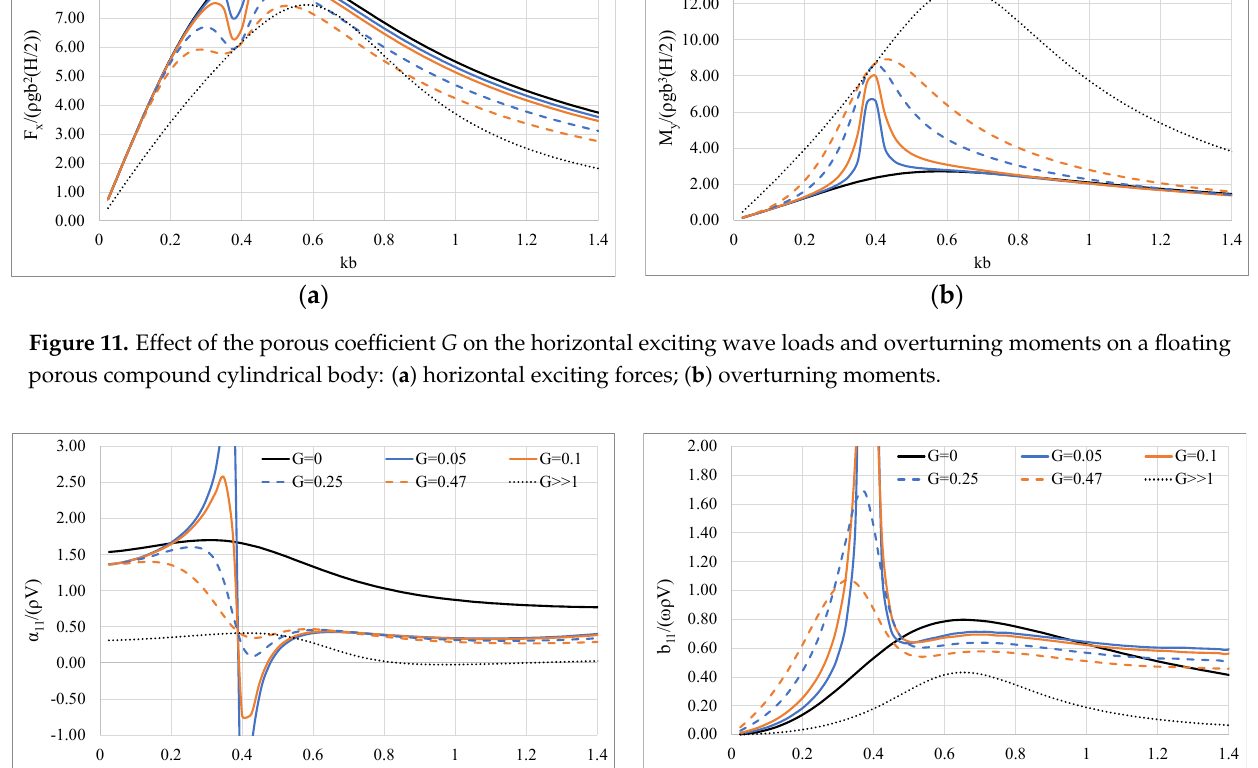
Figure 13. Effect of the porous coefficient 𝐺 on the mean drift forces on a floating porous compound cylindrical body. Figure 14. Effect of the porous coefficient 𝐺 on the wave run up on a floating porous compound cylindrical body.